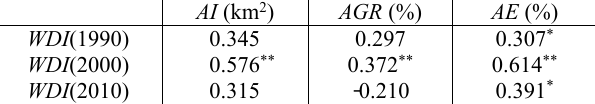
Table 2. Spearman's rank correlation coefficient between